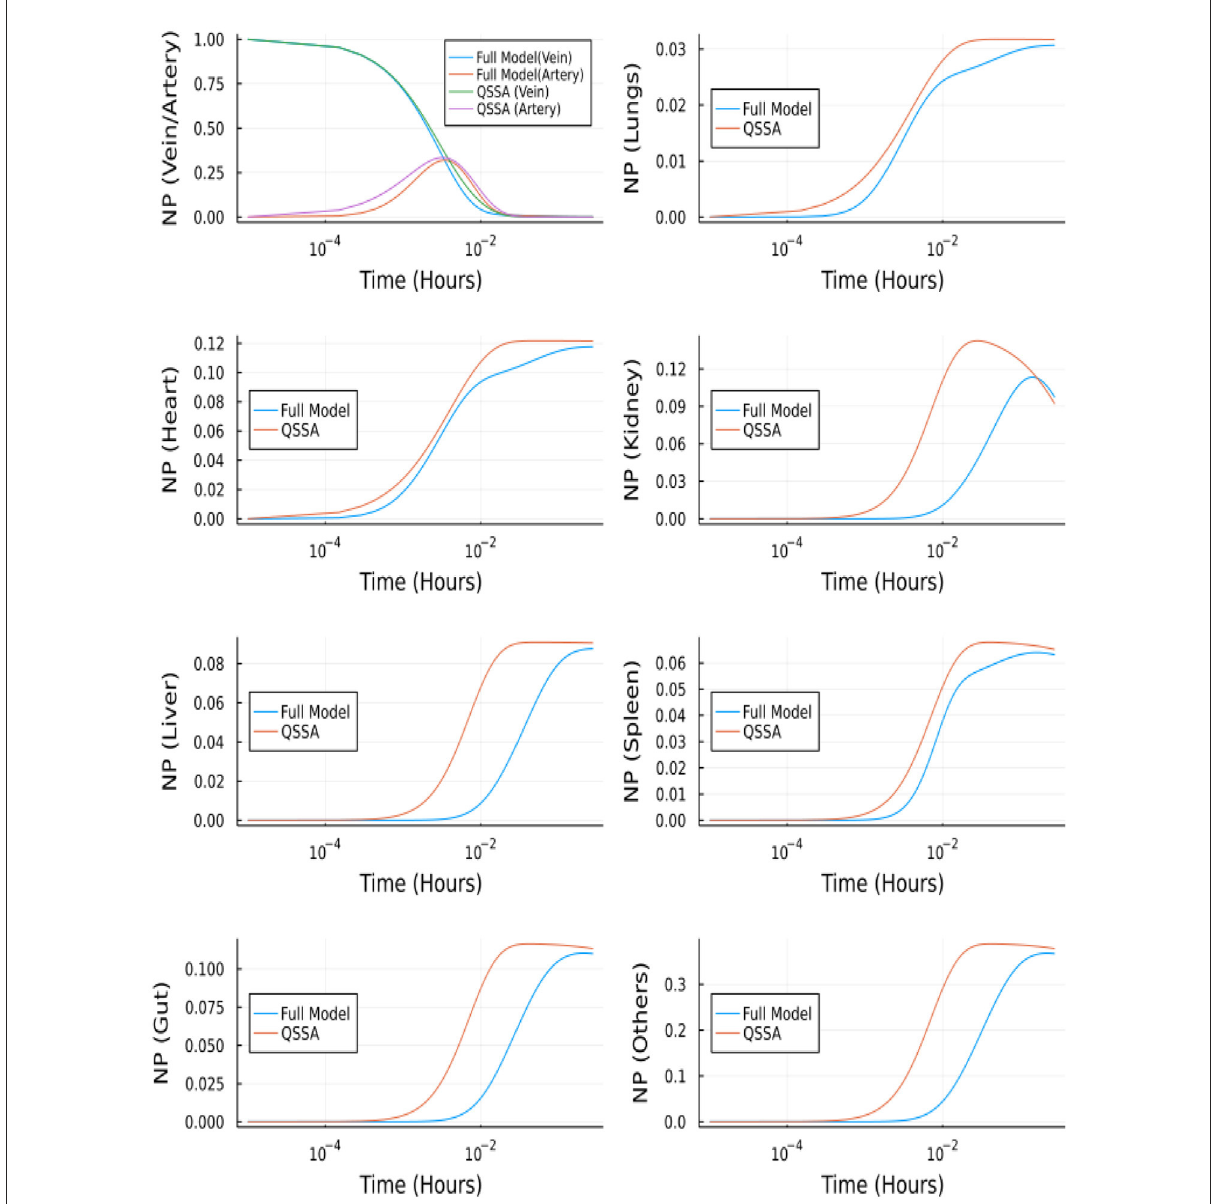
FIGURE12 Comparison between complete model and QSSA for unbranched